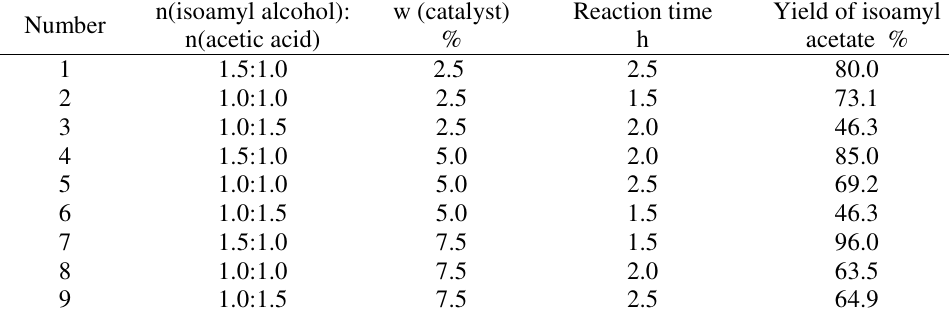
(3 4 ) for the synthesis of isoamyl 9